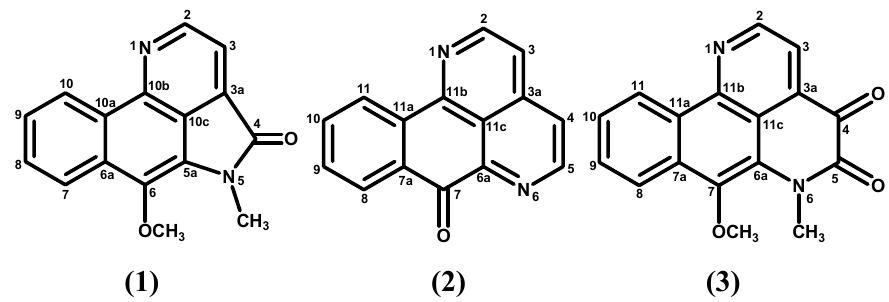
Figure 1. Alkaloids isolated from Anaxagorea dolichocarpa .